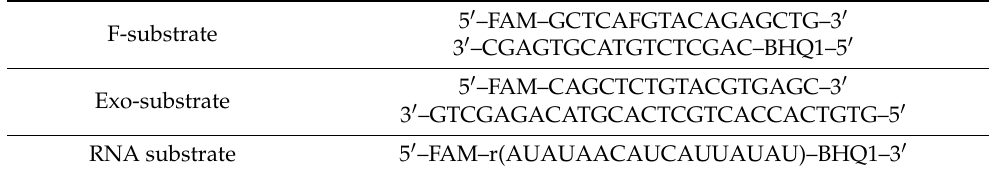
Table 1. DNA substrates used in this study a